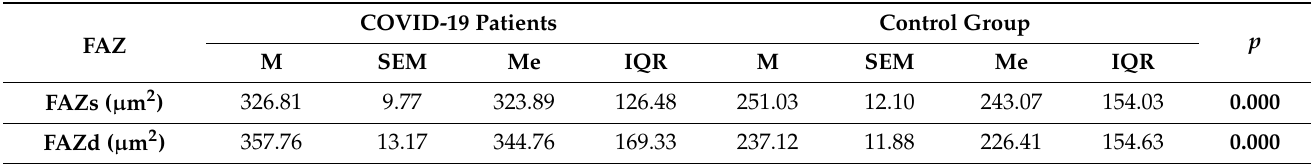
Table 2. Comparison of the foveal avascular zone in the superficial capillary plexus (FAZs) and the foveal avascular zone in the deep capillary plexus (FAZd). Bold values denote statistical significance at the p < 0.05